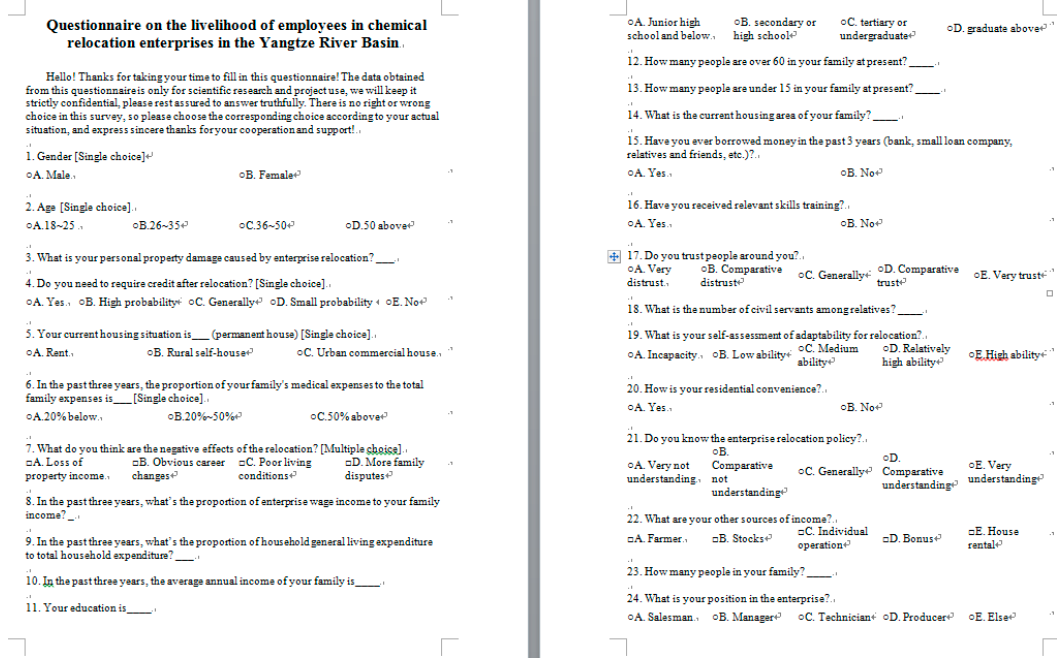
Figure A1. The questionnaire used in the study.